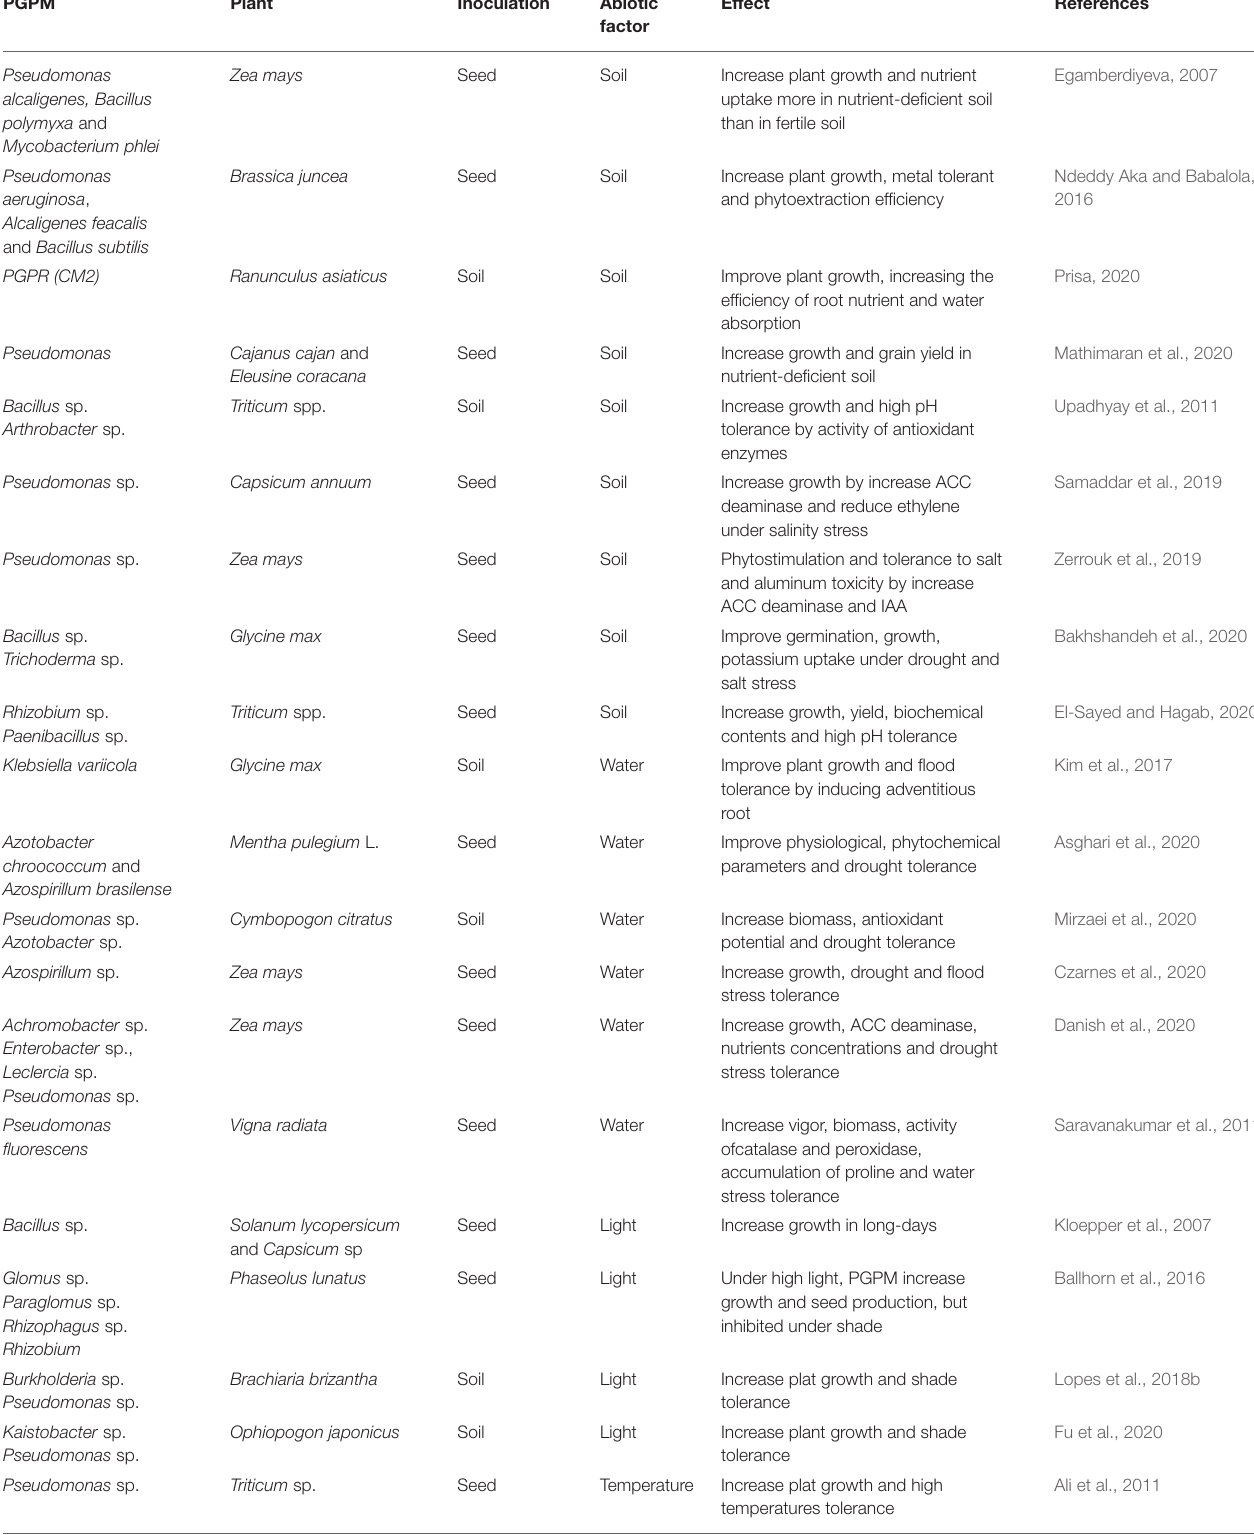
TABLE 2 | Abiotic factors on beneficial plant-microbe